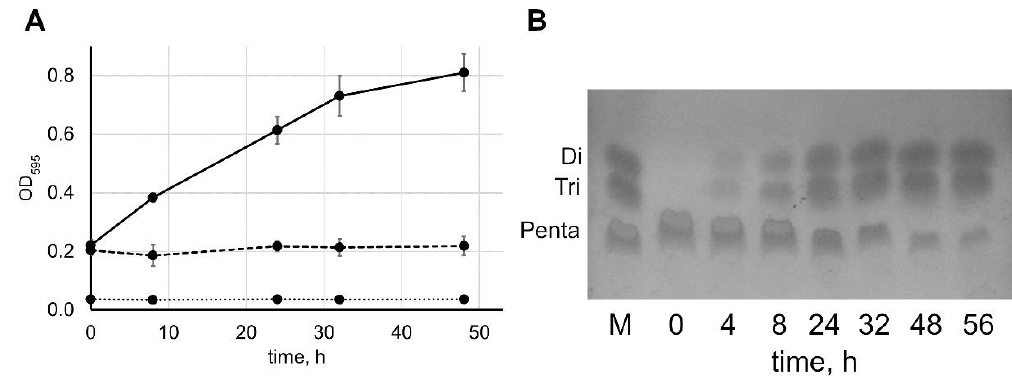
Figure 1. Hydrolysis of pentaglycine by lysostaphin monitored by the chromogenic reaction with ninhydrin and thin-layer chromatography. ( A ) We mixed 4 mM pentaglycine in 20 mM 4-(2-hydroxyethyl)-1-piperazineethanesulfonic acid (HEPES), pH 7.5, with 5 µM (solid line) lysostaphin, or without lysostaphin (dashed line); incubated the mixture at 37 °C for 0–48 h; and treated it with ninhydrin. The dotted line represents 5 µM lysostaphin alone (without pentaglycine) treated in the same way. Average results from six (5 µM lysostaphin), two (without lysostaphin), or one (without pentaglycine) independent experiments are shown; error bars represent standard deviation, and the OD 595 readings without lysostaphin were equal to the OD 595 of the empty wells. ( B ) We mixed 4 mM pentaglycine in 20 mM HEPES, pH 7.5, with 5 µM lysostaphin; incubated the mixture at 37 °C for 0–56 h; and separated the reaction products by thin-layer chromatography. M—marker (a mixture of 3 mM di-, tri-, and pentaglycine).